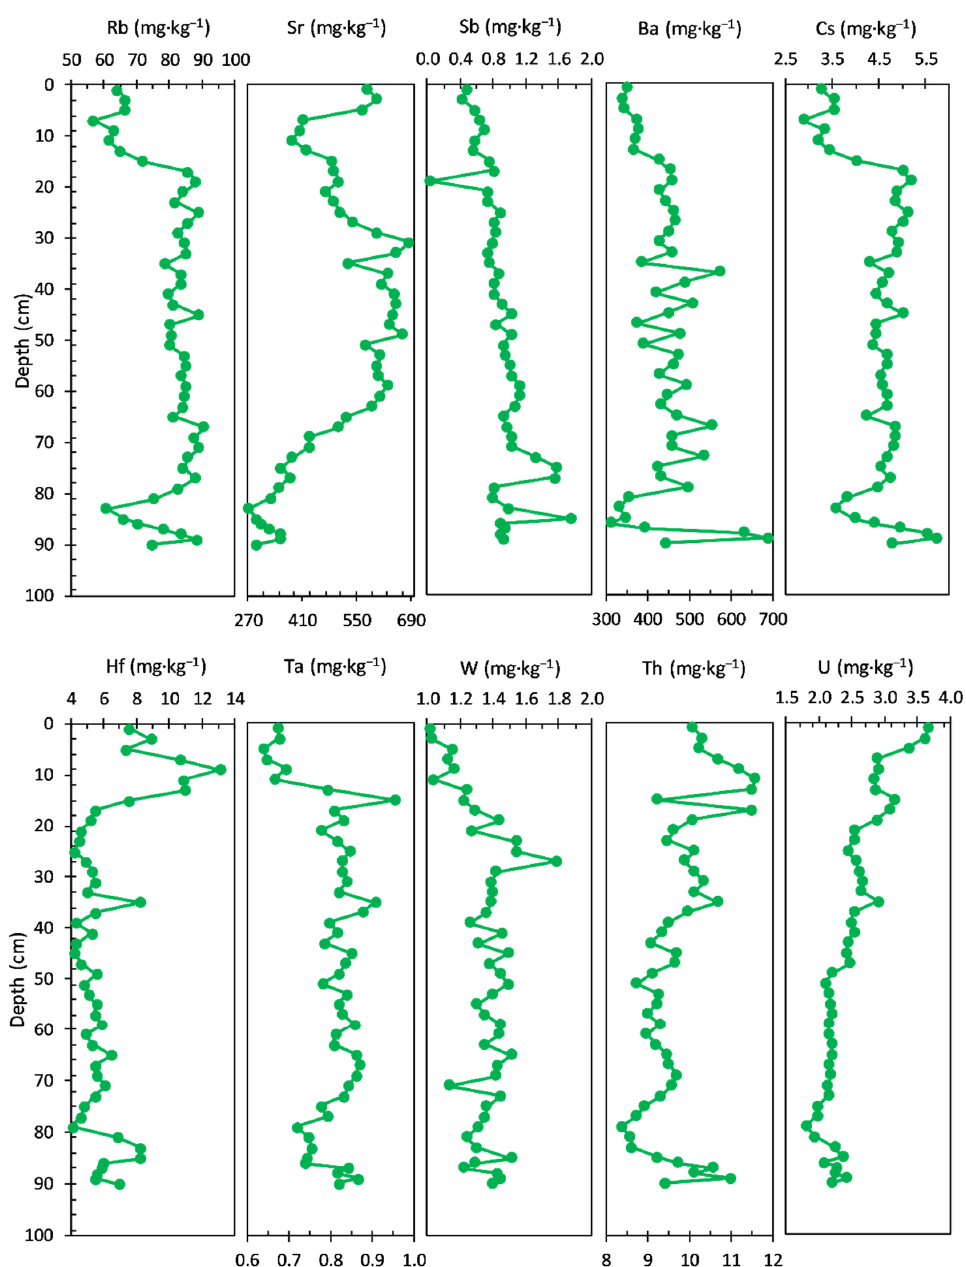
Figure 13. Vertical distribution of geochemical trace elements (Rb, Sr, Sb, Ba, Cs, Hf, Ta, W, Th, U) in the Movila Miresii Lake sediment core (90 cm depth).